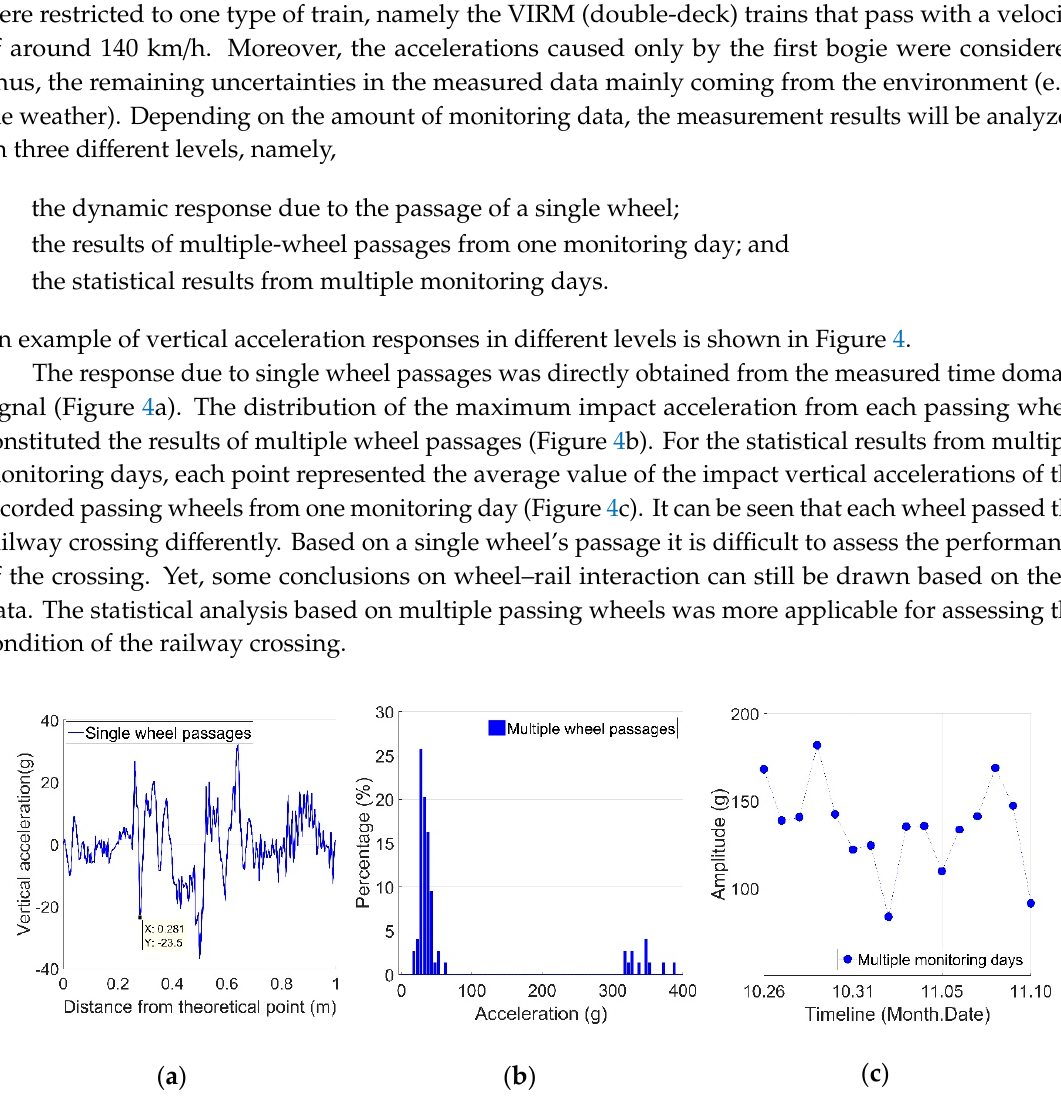
Figure 4. Example of measured vertical acceleration responses: ( a ) from single-wheel passages; ( b ) from multiple-wheel passages from one monitoring day; ( c ) from multiple monitoring days.